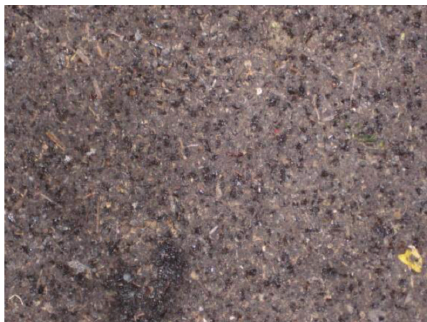
Figure 2: Compost sample from West